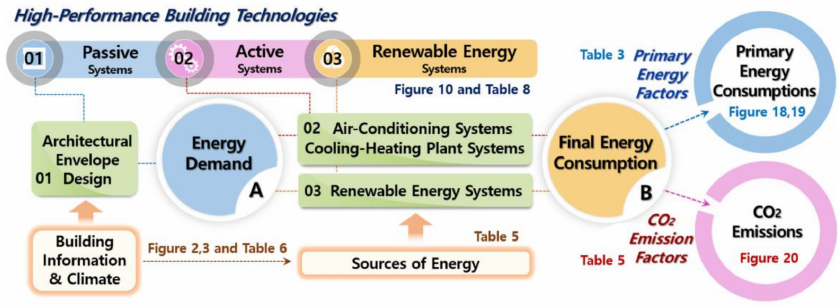
Figure 7. Diagram of primary energy consumption and CO 2 emissions of buildings.